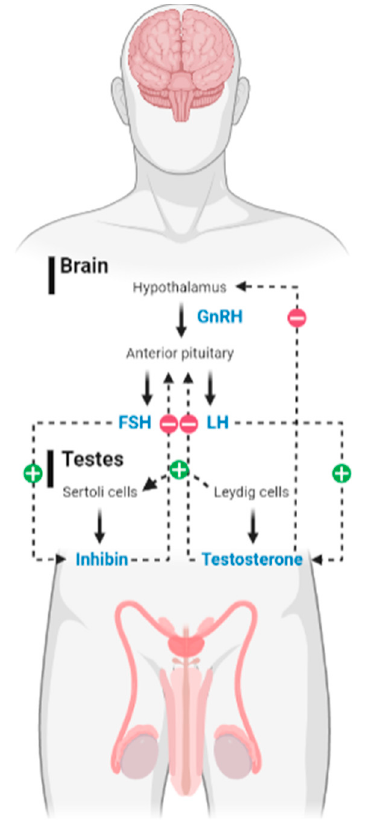
Figure 1. Overview of the hormonal interaction in hypothalamus-pituitary-gonadal (HPG) axis. The hypothalamic-pituitary-gonadal (HPG) axis boils down to a highly regulated system whose main function is to ensure androgen biosynthesis and promote spermatogenesis. This process revolves around a hormonal balance. As such, it simultaneously requires the generation of stimulatory and inhibitory impulses. In this image, the bold arrows indicate the secretion of hormones; the dotted arrows represent the stimulating (+) or inhibitory ( − ) effect of the secreted hormones. In short, the hypothalamus generates pulses of gonadotropin-releasing hormone (GnRH) that reach the pituitary, inciting it to produce follicle-stimulating hormone (FSH) and luteinizing hormone (LH). In turn, these glycoproteins act on the Sertoli cells (SCs) and the Leydig cells (LCs), respectively. This interaction results in the production of other hormones, such as testosterone by LCs and inhibin by the SCs, which generate negative feedback impulses to the central command of the axis, thus maintaining a balance of hormone synthesis and secretion. LCs also have some mechanisms that allow them to stimulate SCs directly.